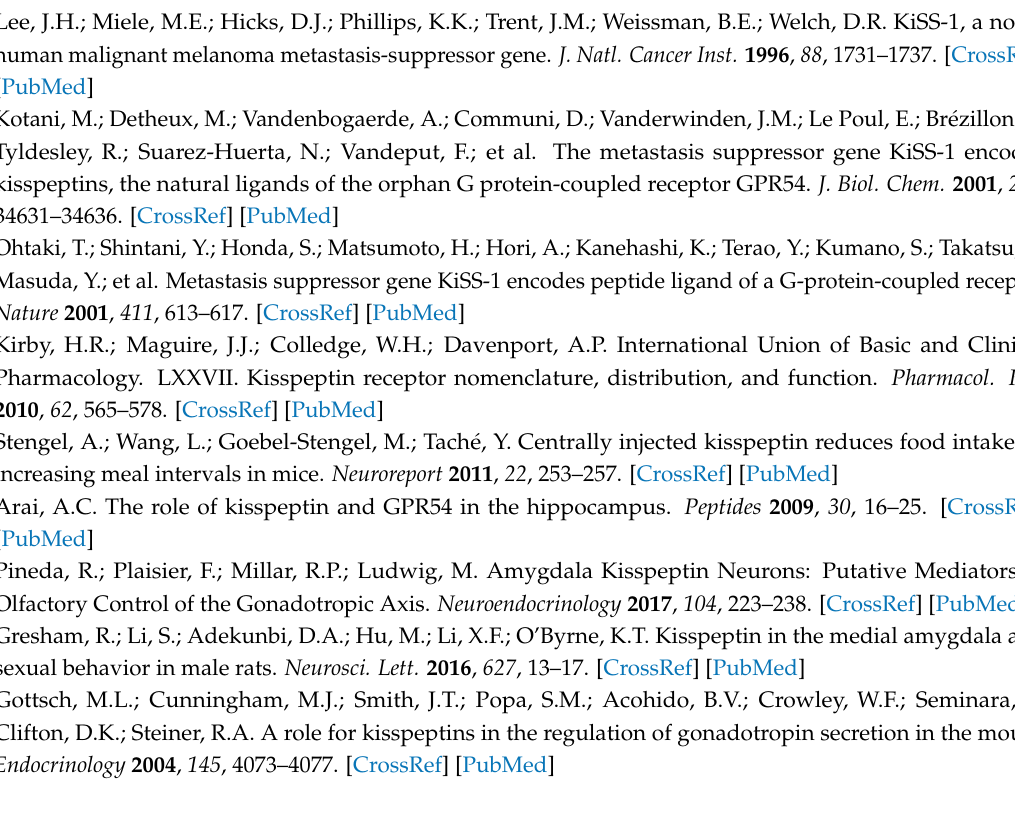
Supplementary Materials: The following are available online. Figure S1 a: Kisspeptin structure; Figure S2 MTT: cell viability; Tables S1–S4: HPLC-EC method; Scheme S1: Kisspeptin 10